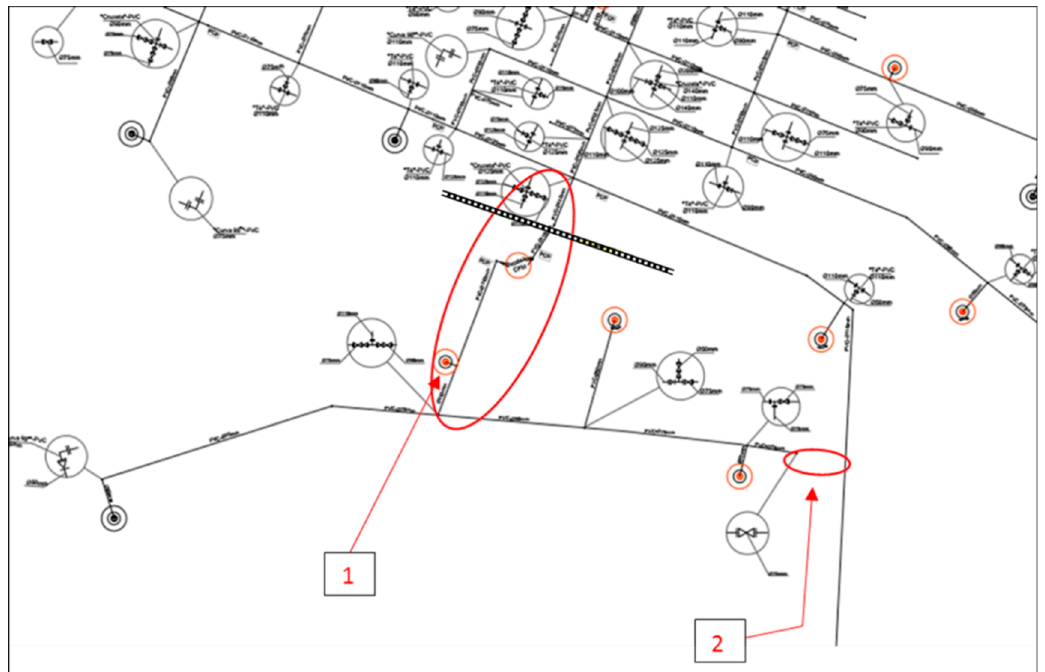
Figure 2. 2008 design map of the water distribution network in Bairro Central. Red circle 1 shows the proposed pipeline under the railway. Red circle 2 shows the absence of the pipe connecting to Bairro Central (source: Collins Sistemas de Agua Lda.).